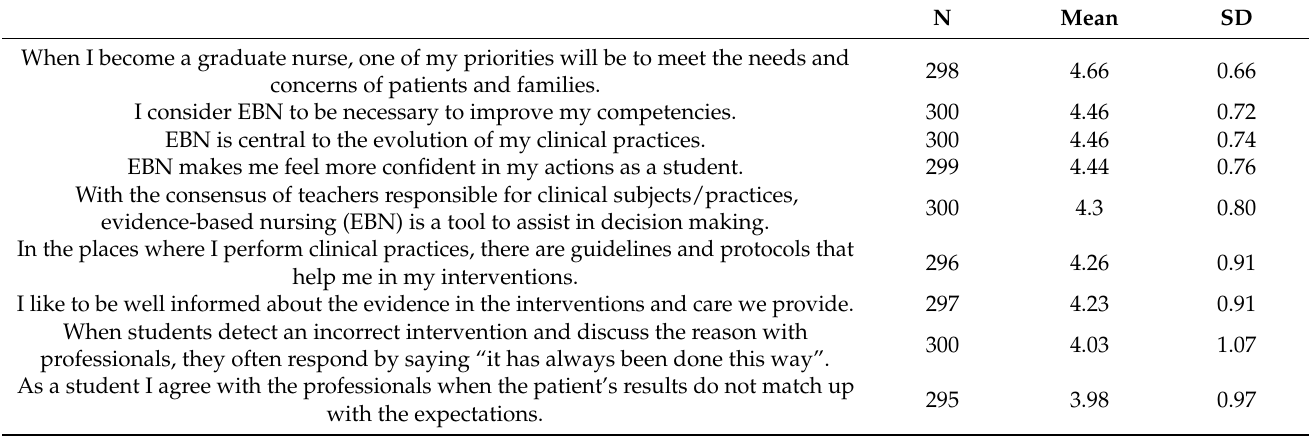
Table 1. Descriptive data of the questionnaire items, mean and standard deviation (N = 304).